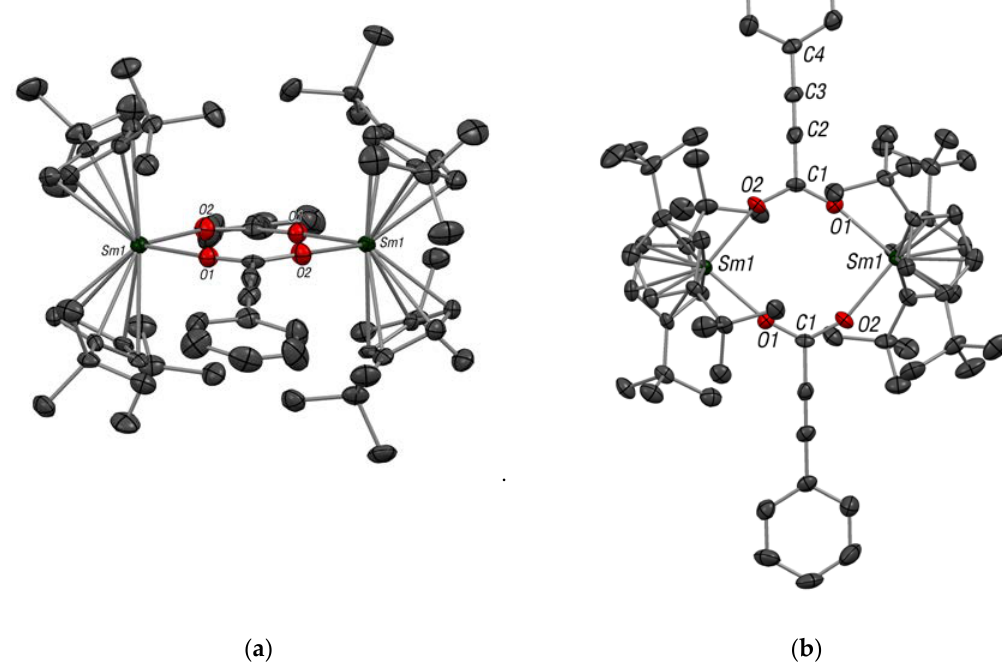
Figure 2. ORTEP of 2 : ( a ) side view; ( b ) top view. Thermal ellipsoids are set to 50% probability level; H-atoms have been removed for clarity. Selected distances (in Å): Sm1–ctr (av.) 2.45(1); Sm1–O1